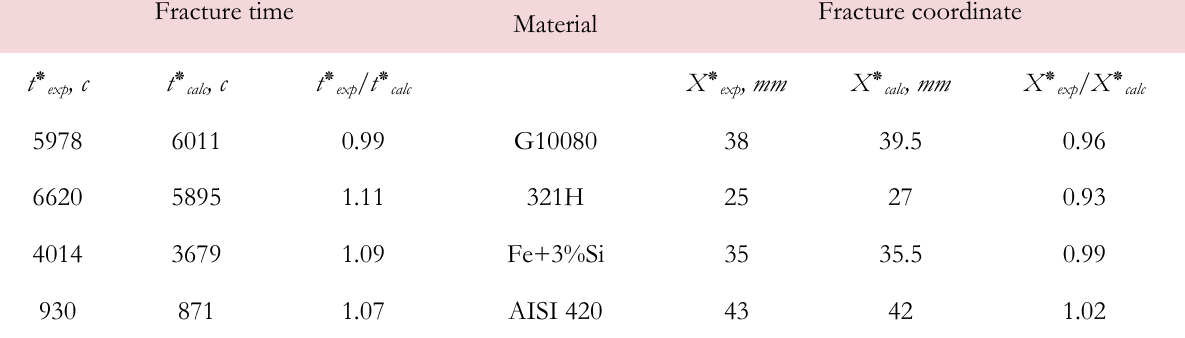
Table 4: Comparison of the experimental and calculated coordinates and the fracture time of the